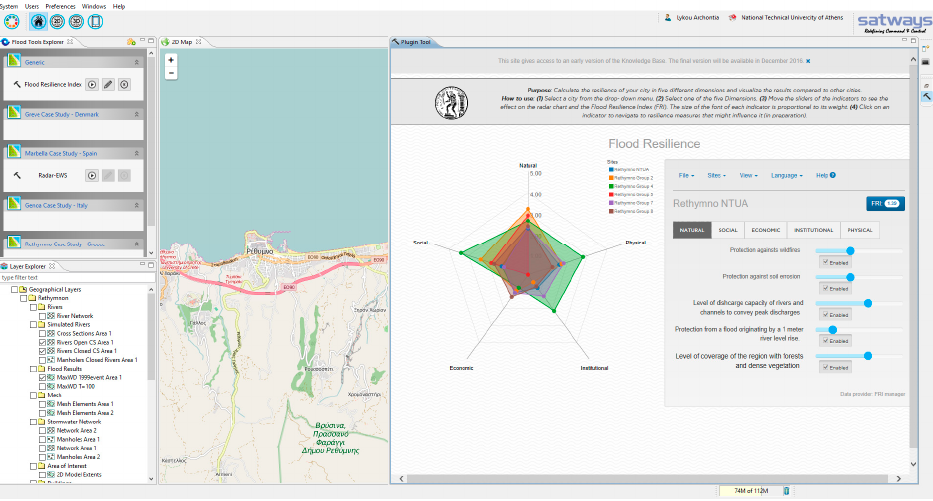
Figure 15. Selection and execution of the Flood Resilience Index web plugin.